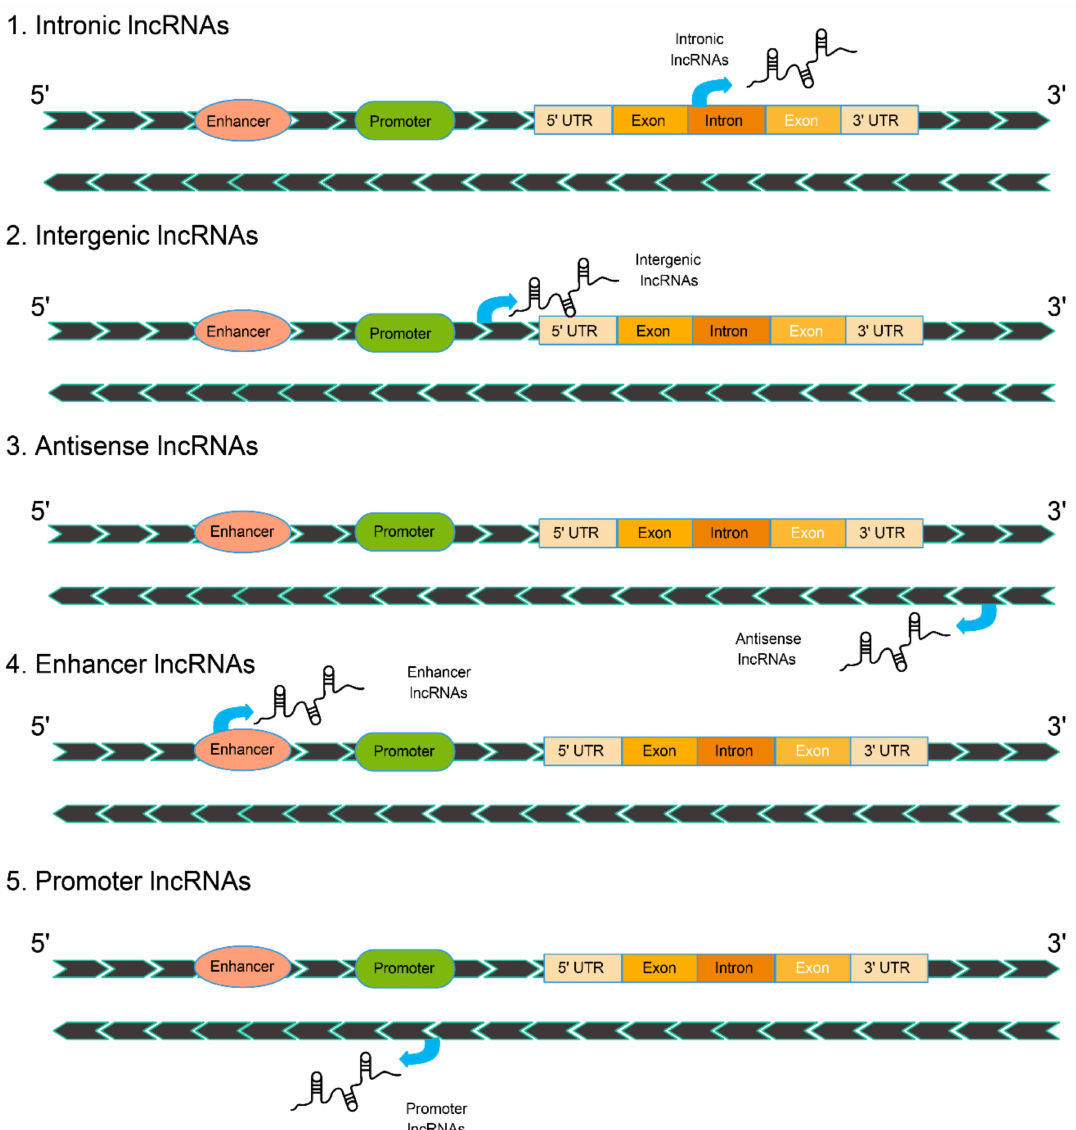
Figure 1. The biogenesis of long noncoding RNAs (lncRNAs) according to their locations and transcriptional origins. According to their mechanism of action, lncRNAs can be classified into four types (Figure 2): signal, decoy, guide, and scaffold [53,54]. The signal mechanism involves lncR- NAs regulating downstream genes [55]. Previous studies have shown that lncRNAs